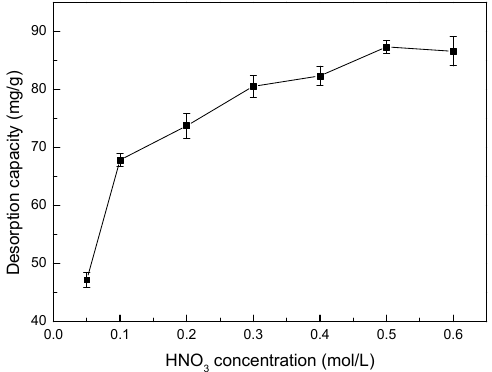
Figure 14. Effect of nitric acid (HNO 3 ) concentration on desorption capacity of LMT.